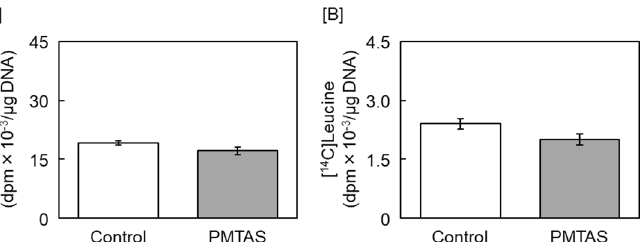
Figure 4. Effects of PMTAS on the incorporation of [ 3 H]thymidine and [ 14 C]leucine into the acid- insoluble fraction of vascular endothelial cells. The cells were treated with PMTAS (10 µM) for 24 h and labeled with ( A ) [ 3 H]thymidine and ( B ) [ 14 C]leucine during the last 6 h of treatment. Values are means ± S.E. of four samples.